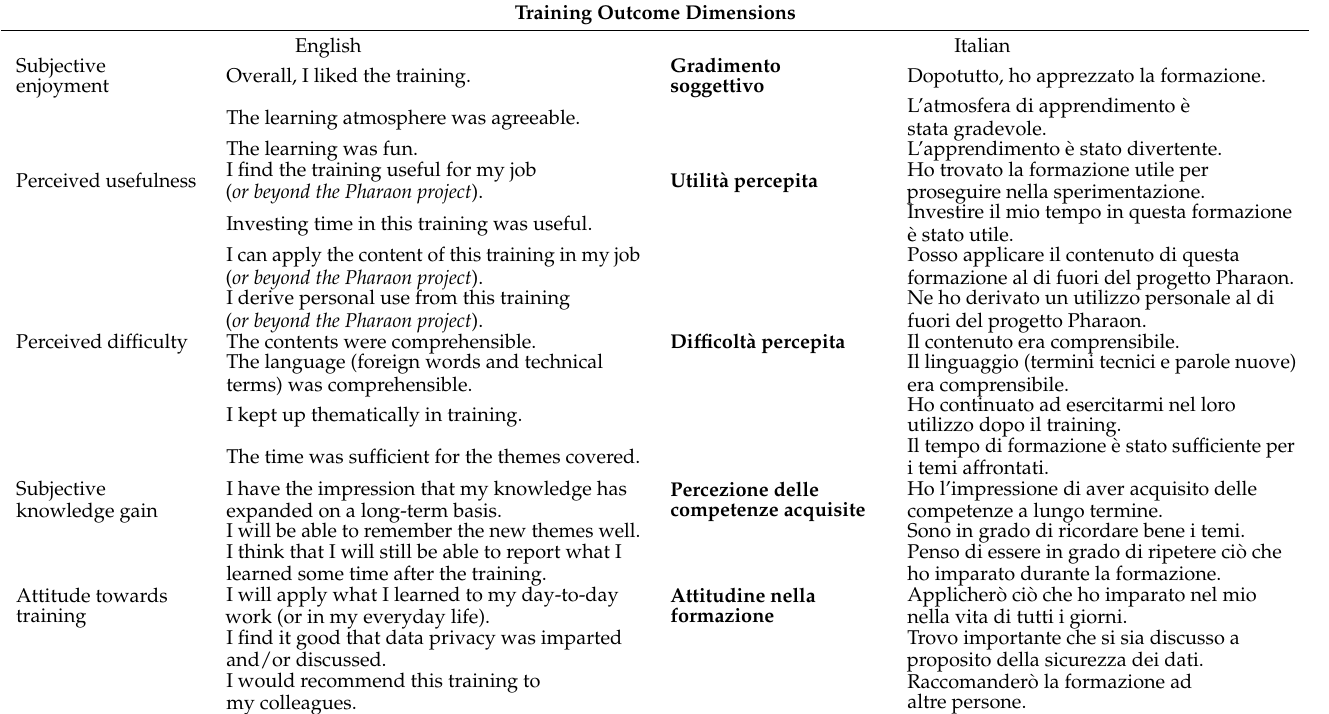
Table A3. The first seventeen items scales of the TEI in English and Italian. Training Outcome